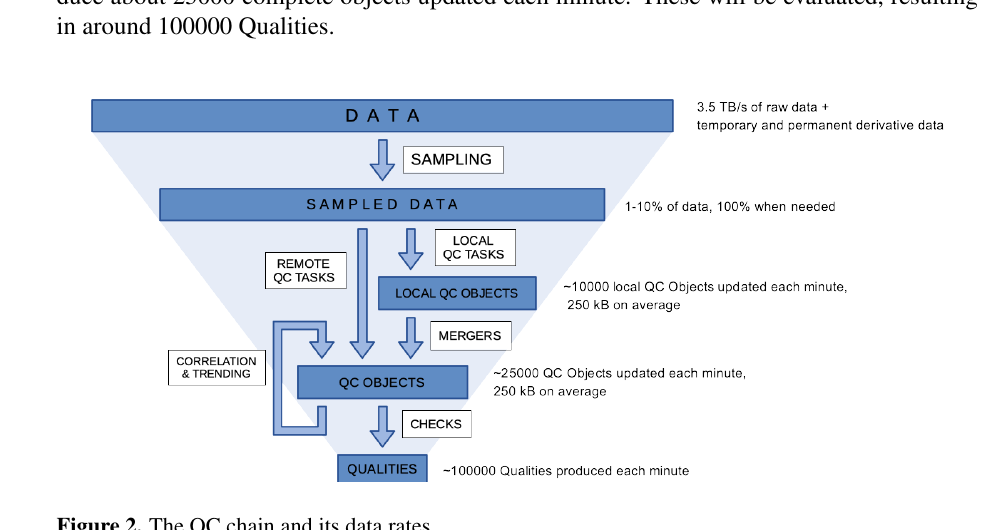
Figure 2. The QC chain and its data